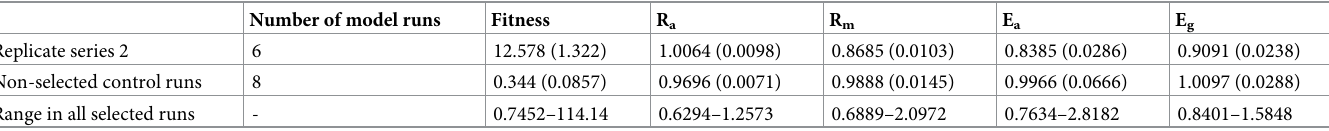
Table 2. Results from non-selected model